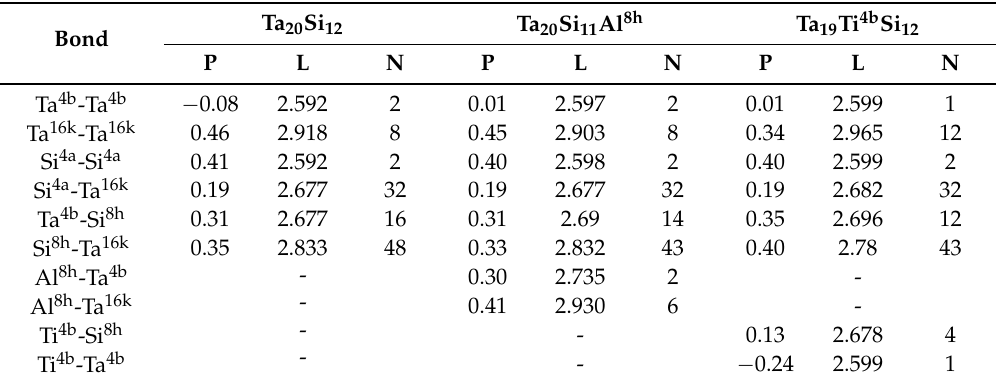
Data in the Table 3 are average values; P: Mulliken populations; L: Bond length (Å); N: Numbers of